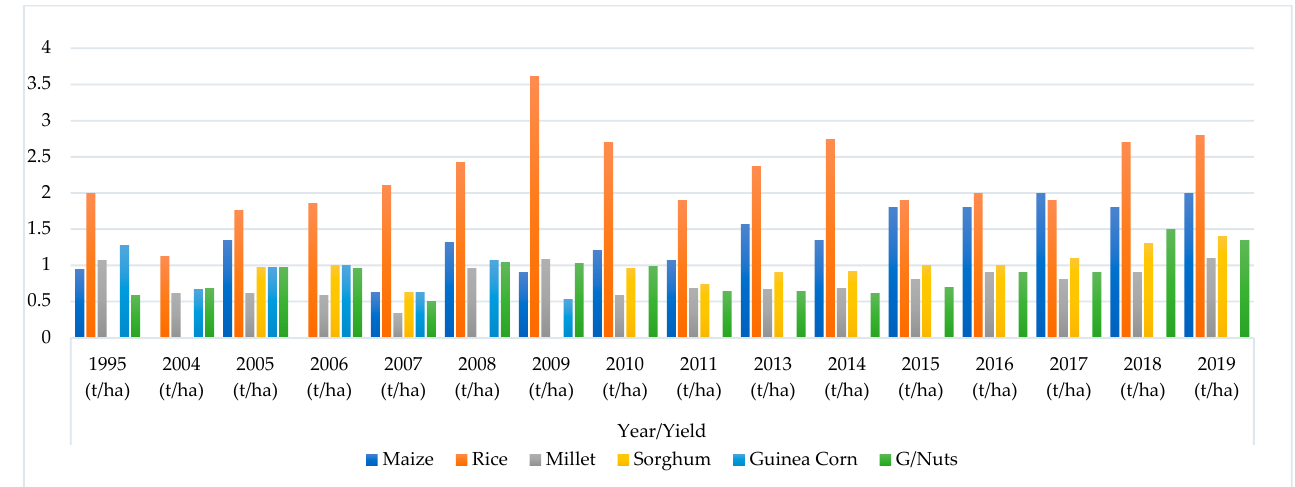
Figure 5. Yield Estimates of Selected Crops in the Bongo District, UER. Source: Statistics, Research and Information Directorate (SRID), Ministry of Food and Agriculture (MOFA) (2020), Bolgatanga.